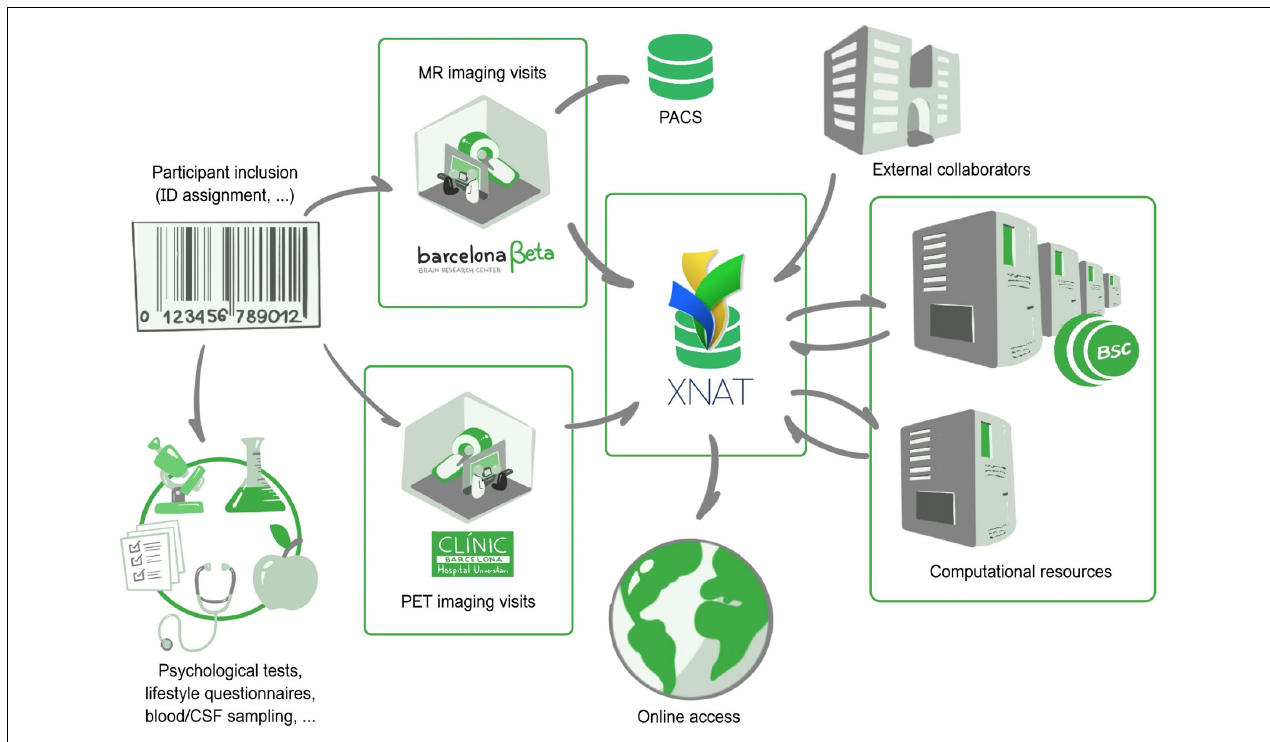
FIGURE 1 | The Barcelona β eta Brain Research Center: general view of the imaging data flow, from patient inclusion to data sharing. Imaging and non-imaging data follow different data flows. Imaging sessions are automatically imported in XNAT from the in-house MR scanner and external PET camera. Processing workflows are sent to computational resources from the Barcelona Supercomputing